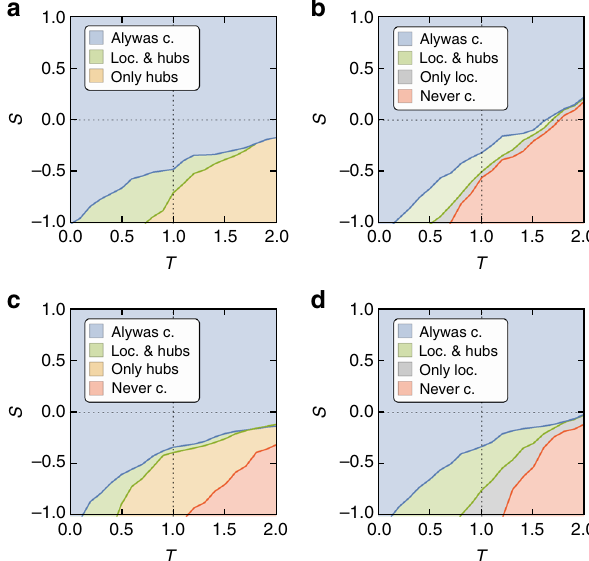
Fig. 4 Game parameter phasespace for different topologies. We show the fi nal density of cooperators (after 2 × 10 5 update steps) averaged over 50 realizations of the system, as a function of the game parameters T and S from Eq. (1). Colors denote regions in the parameter space where fi nal cooperation exceeds the threshold value of 0.3. This is always the case in the blue area, only if started with either cooperative hubs or a metric cluster in the green region, only if started with cooperative hubs in the yellow area, only if started with metric clusters in the gray area, and for none of the considered initial conditions in the red region. a Results for the IPv6 Internet topology. b Results for the arXiv collaboration network. c Synthetic network with N = 2 × 10 4 nodes, power-law exponent γ = 2.4, mean degree k h i ≈ 6, and clustering c ¼ 0 : 5. d The same as before but for networks with power- law exponent γ = 2.9 and clustering c ¼ 0 :